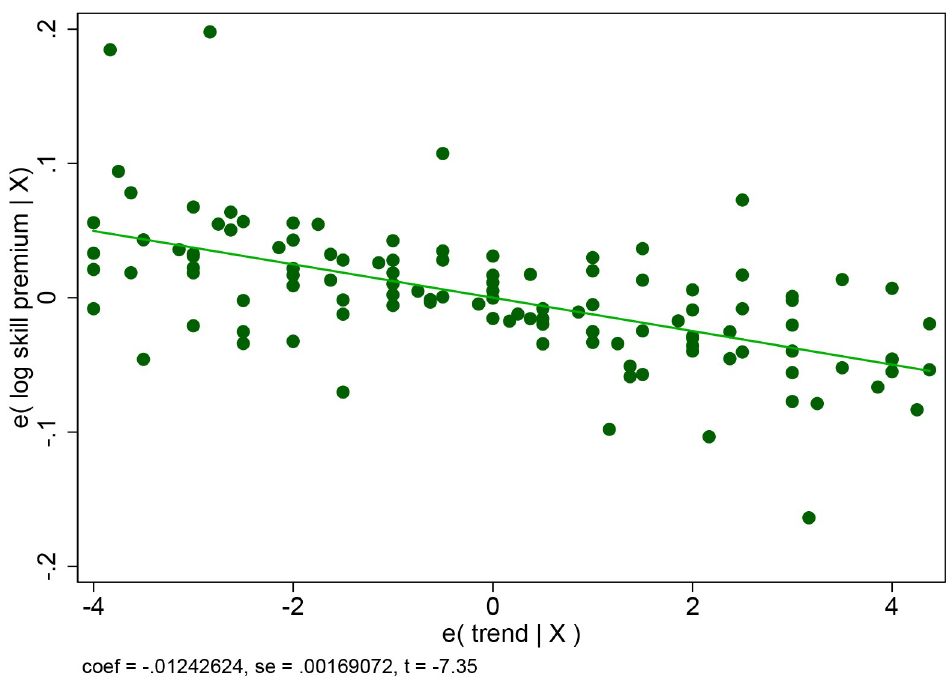
Fig 2. Evolution of wage skill premium, 2004-2012. This is the partial plot of a regression of the log of the wage gap between skilled and unskilled workers on a time trend and country fixed effects for countries in our sample with more than 7 observations over the period